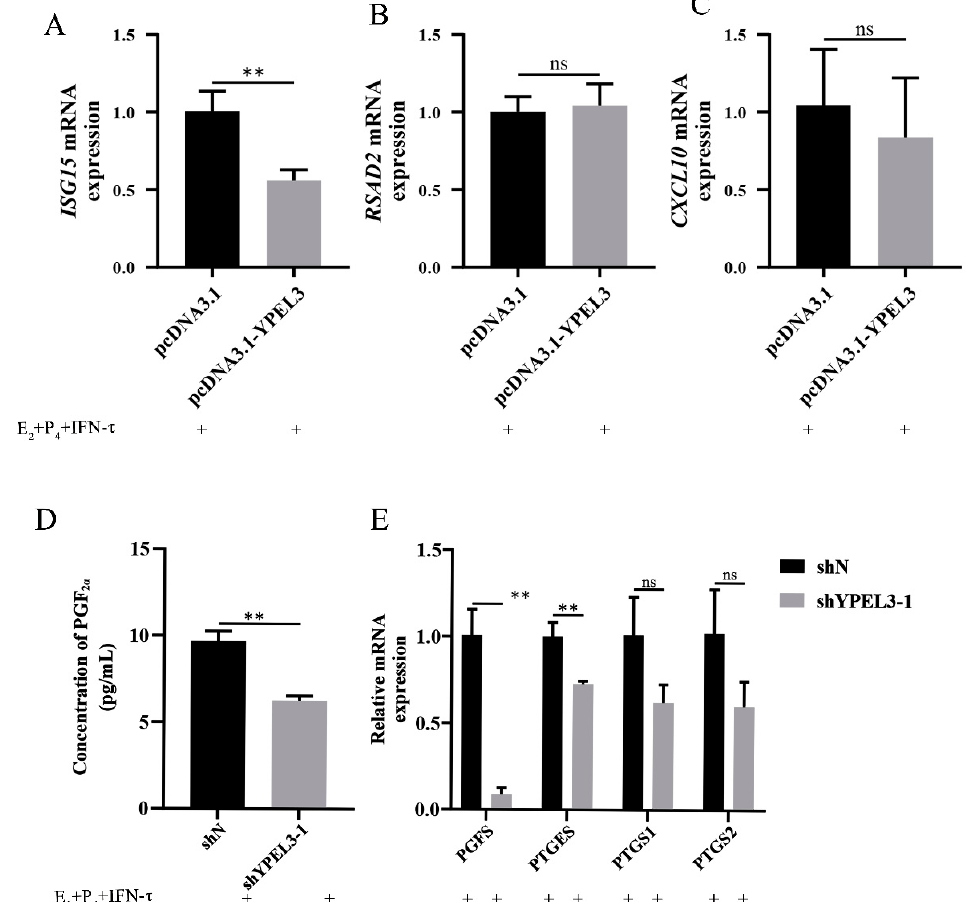
Figure 3. YPEL3 altered endometrial receptivity and the secretion of PGF 2 α . ( A – C ) Real-time quantitative PCR analysis of the expression of genes ( ISG15 , RSAD2 , CXCL10 ) associated with promoting conceptus elongation in gEECs overexpressing YPEL3 and treated with E 2 , P 4 and IFN- τ . ( D ) ELISA analysis of PGF 2 α secretion by gEECs with YEPL3 silencing and treated with E 2 , P 4 and IFN- τ . ( E ) Real-time quantitative PCR analysis of the expression of genes encoding rate-limiting PG synthesis enzymes ( PGFS , PTGES , PTGS1 , PTGS2 ) in gEECs with YEPL3 silencing and treated with E 2 , P 4 and IFN- τ . ** p < 0.01, ns, not significant ( p > 0.05).